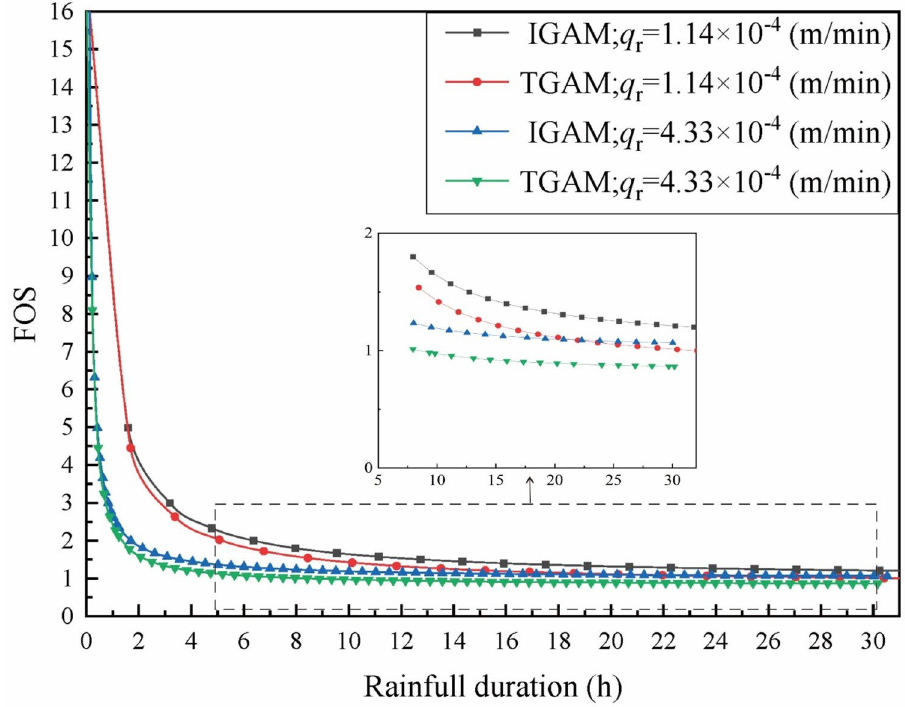
Figure 8. Variation of stability coefficient with rainfall time under different rainfall